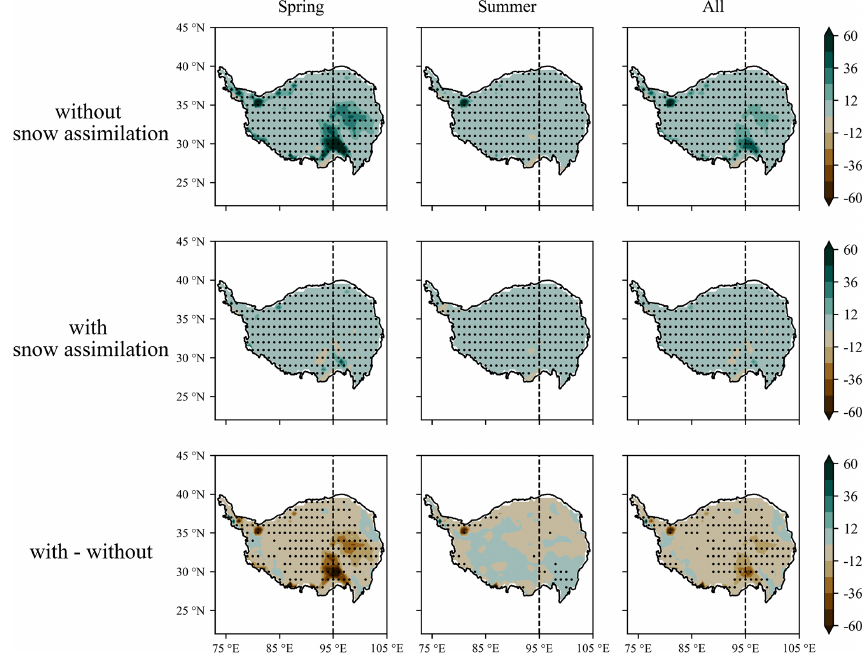
Figure 4. The spatial differences in snow depth (cm) between the ensemble reforecasts and TPSD (top and middle rows) and between the two reforecasts (bottom row). The stippled regions show the statistical significance of the differences identified by the t test at a 5% significance